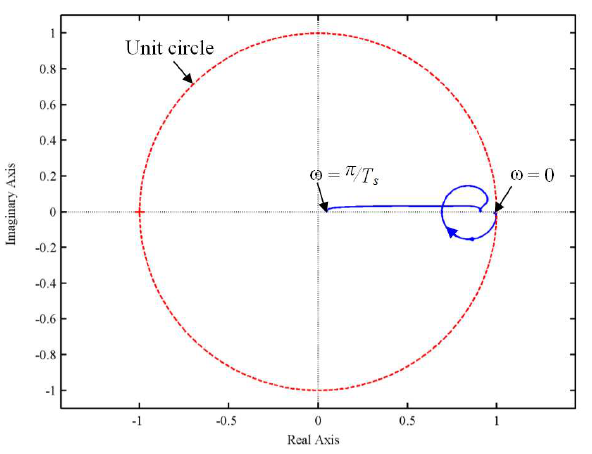
Figure 10. Locus of vector S ( e j ω T s